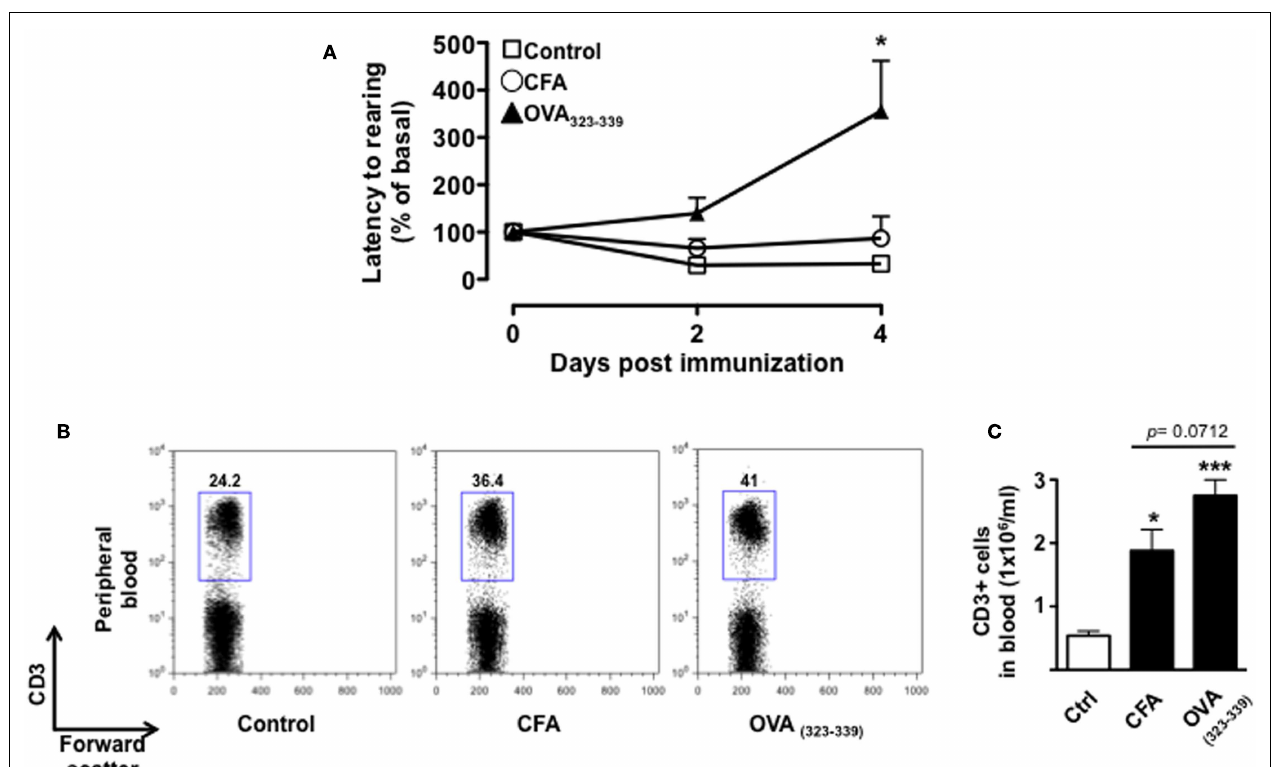
plots (B) show the percentages of CD3 + T cells while the bar graph (C) shows the comparison of the total number of CD3 + T cells in peripheral blood of control, CFA only or OVA 323–339 -immunized mice at day 4.The results are representative of n = 6–8 mice.